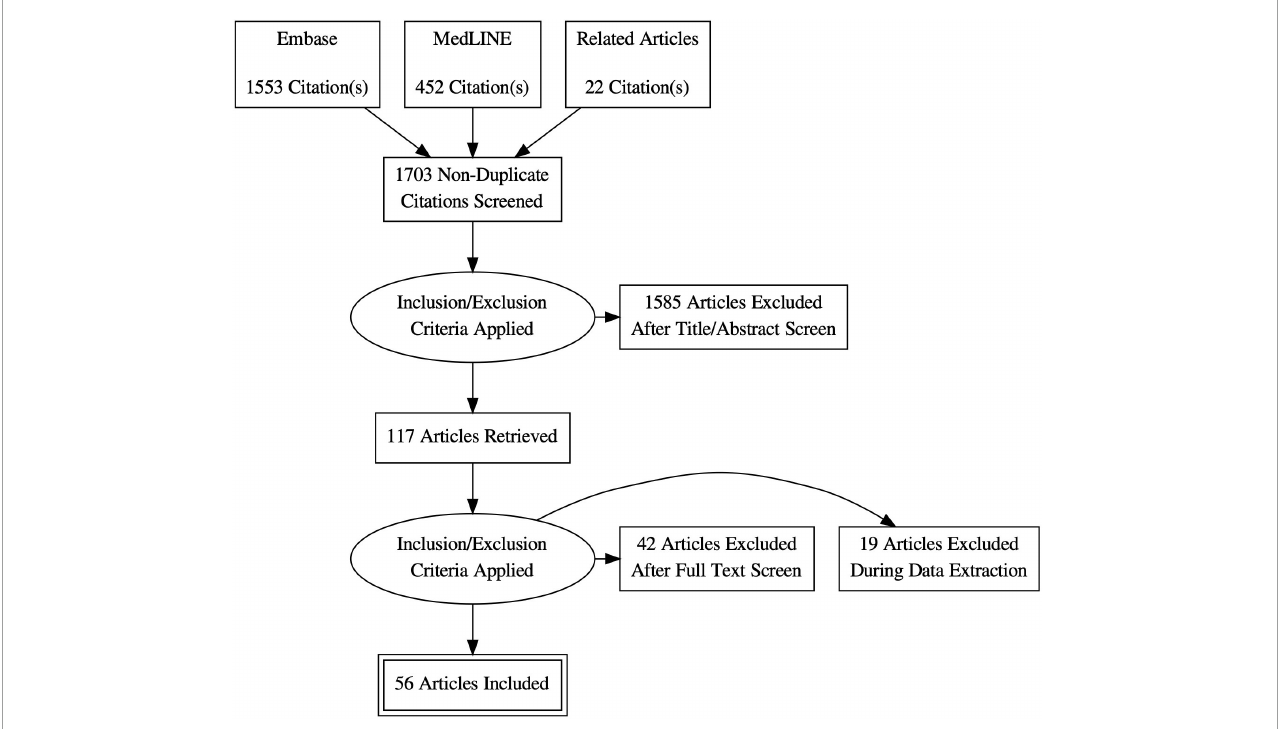
FIGURE1 Flow chart of literature search. Created with: PRISMA flow diagram generator.